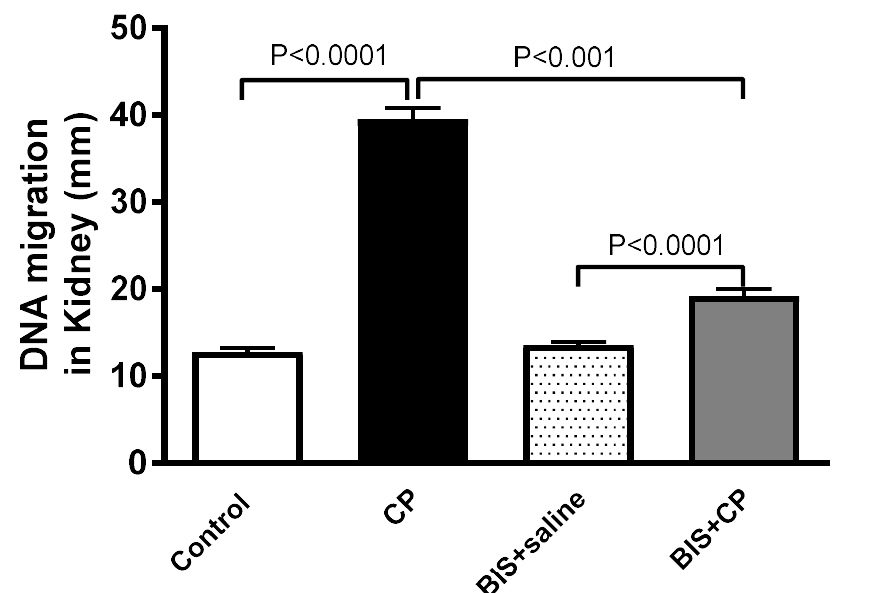
Figure 7. DNA migration (mm) in kidney tissue assessed by Comet assay in mice treated orally with either sunflower oil (control) or bisabolol (BIS, 25 mg/kg) with or without cisplatin (CP, 20 mg/kg) given intraperitoneally (n = 5). Mean ± SEM. Statistical analysis by ANOVA 1 followed by Holm Sidak’s test.